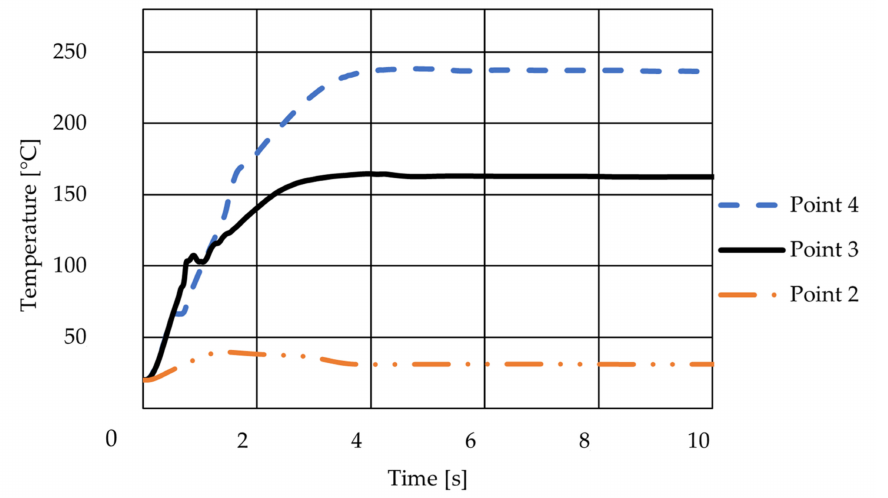
Figure 7. Graph of calculated temperatures by simulation at selected points of the basic